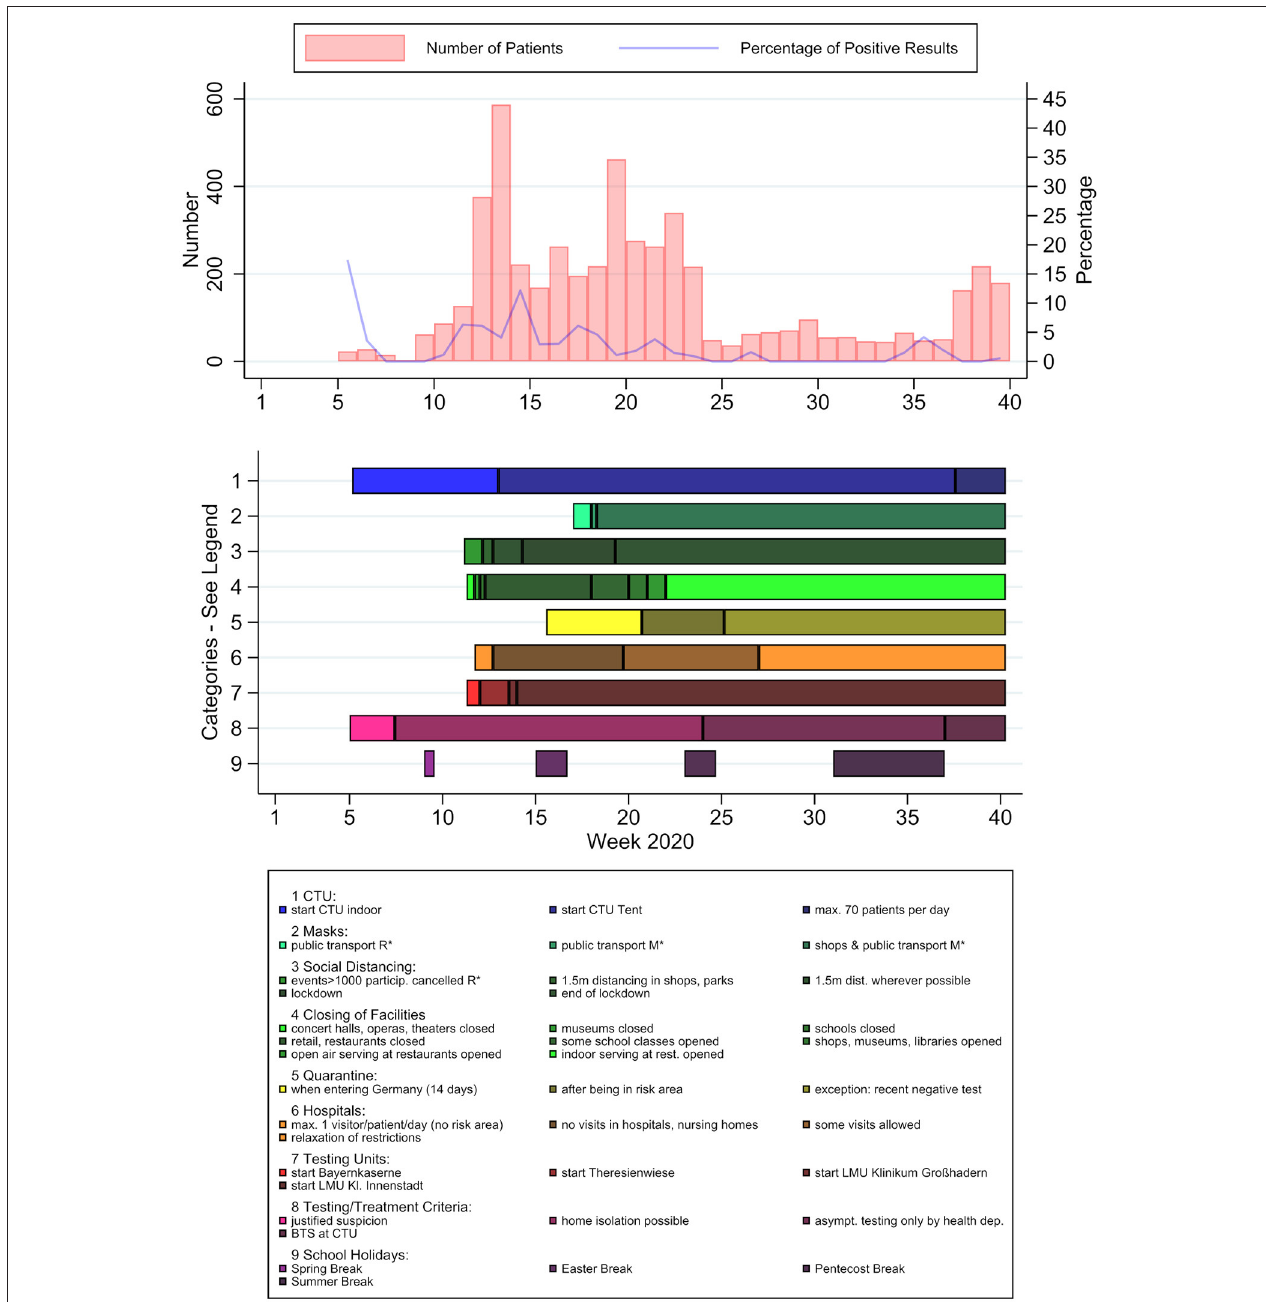
FIGURE 5 | PCR-test results and potential influencing factors over time. Patient numbers (light red) and positive rates (blue) per calendar week, timeline of potential influencing factors. *R, recommendation; *M,